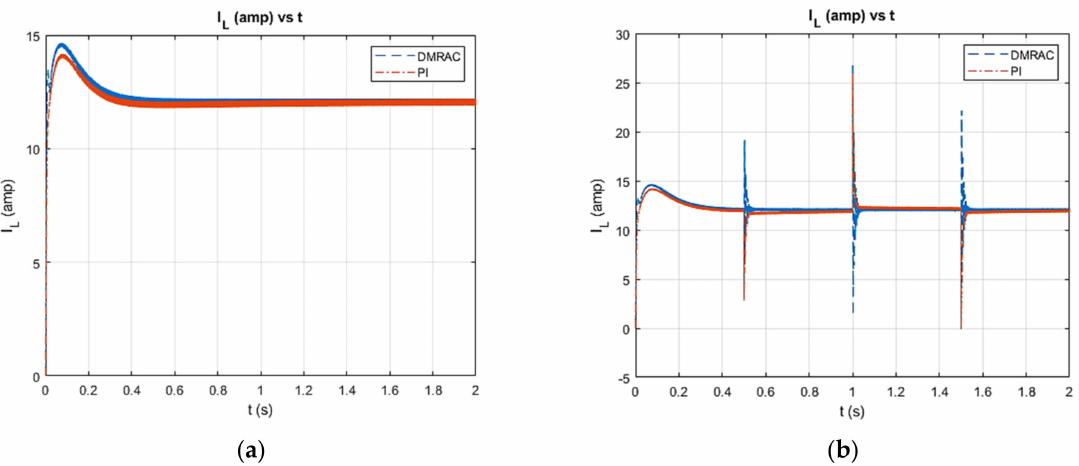
Figure 5. Inductor current ( a ) without the disturbance in the system, and ( b ) in presence of the disturbance in constant voltage tracking.